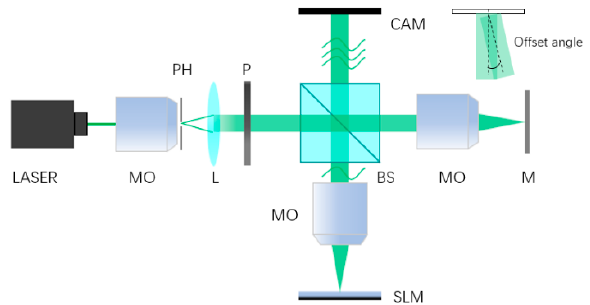
Figure 5. Schematic of the SLM calibration method based on digital holographic microscopy. MO: microscope objective; PH: pinhole filter; L: collimating lens; P: polarizer; BS: beam splitter; M: mirror; SLM: spatial light modulator; CAM: camera. [33] .